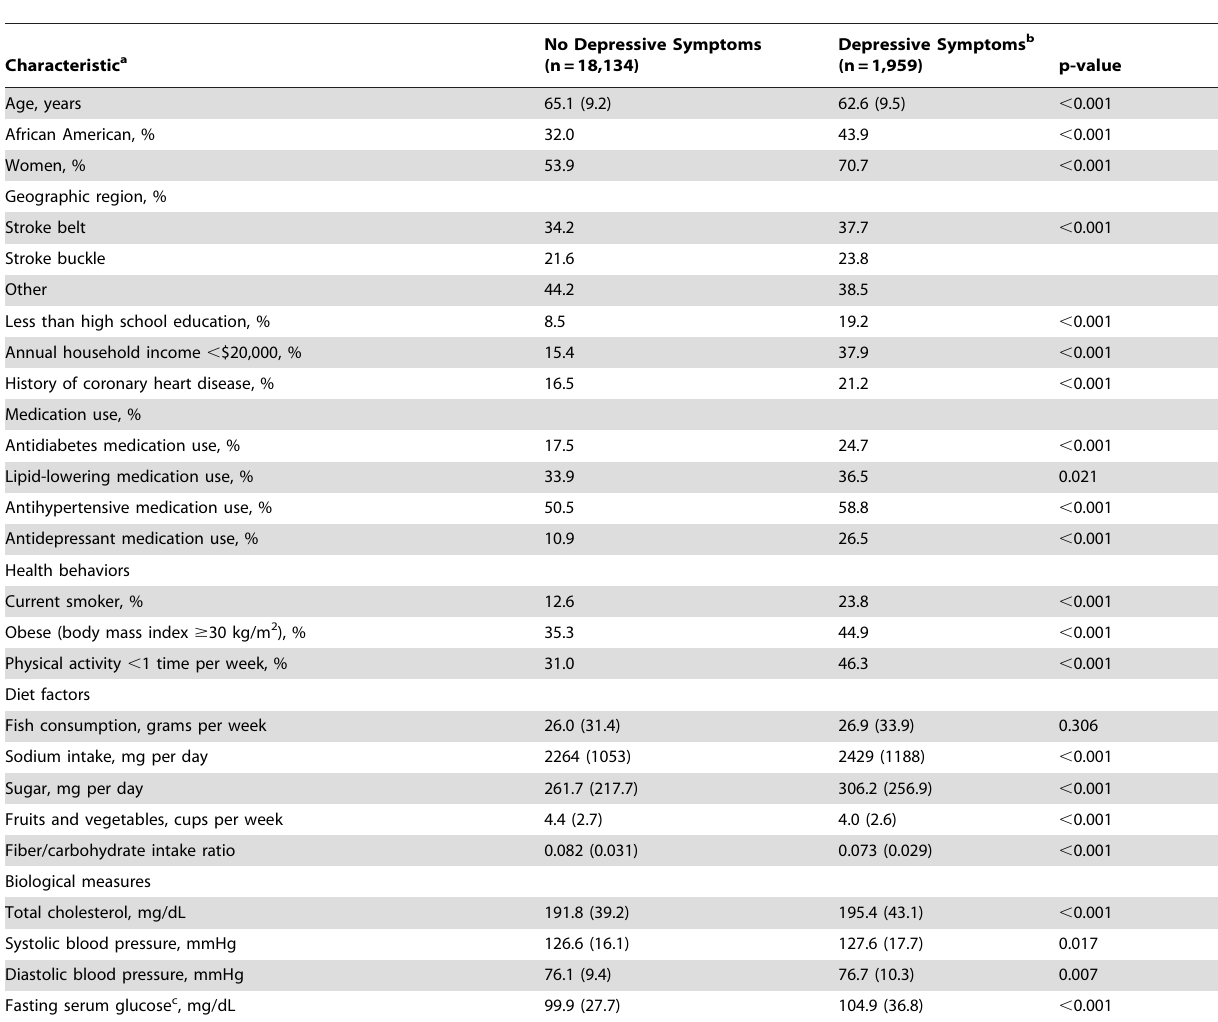
Table 2. Characteristics of REGARDS Study Participants With and Without Depressive